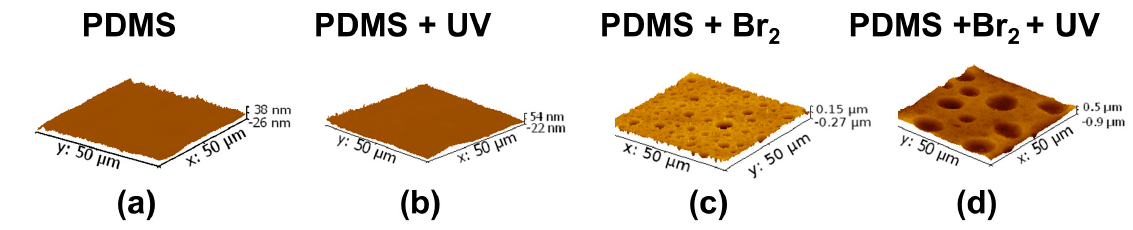
Figure 7. Examples of 3D AFM images: ( a ) Pristine PDMS. ( b ) UV-irradiated sample. ( c ) Sample exposed to Br 2 (g), but not irradiated. ( d ) Sample exposed to Br 2 (g) and then UV-irradiated.